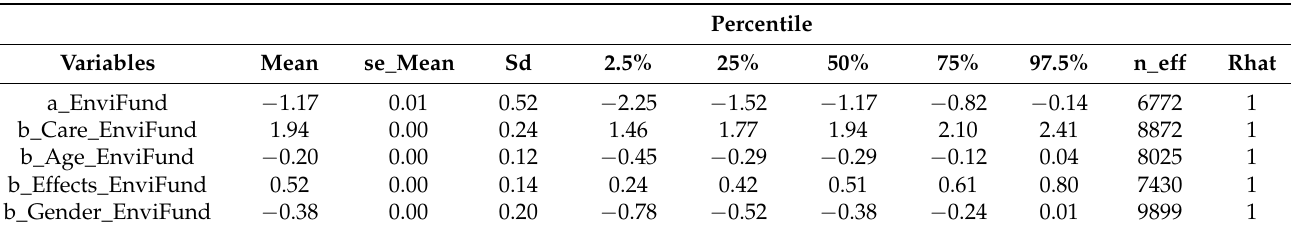
Table 4. Estimated results of environment fund model.